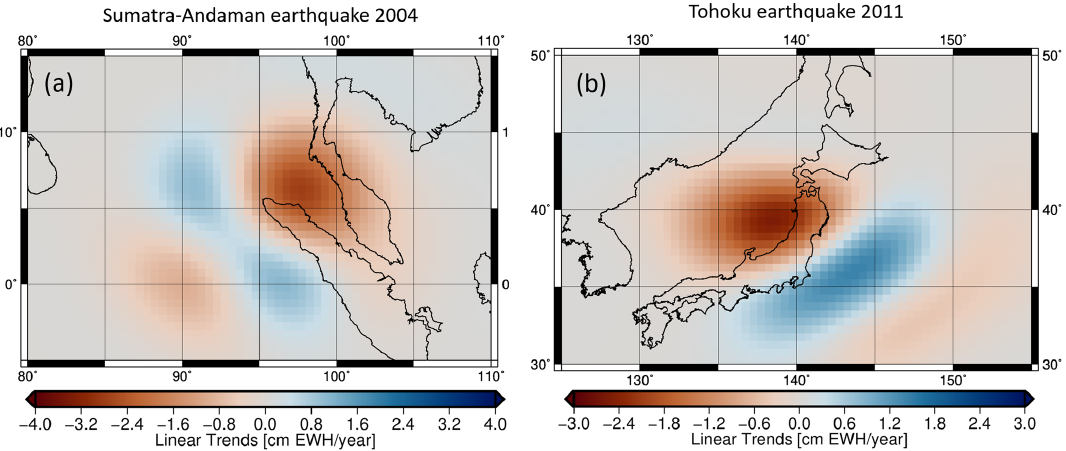
Figure 4. Linear trends (January 2003–December 2016) of TWS changes (cmEWHyr − 1 ) of the earthquake correction that includes the (a) Sumatra–Andaman earthquake from 2004 and the (b) Tohoku earthquake from